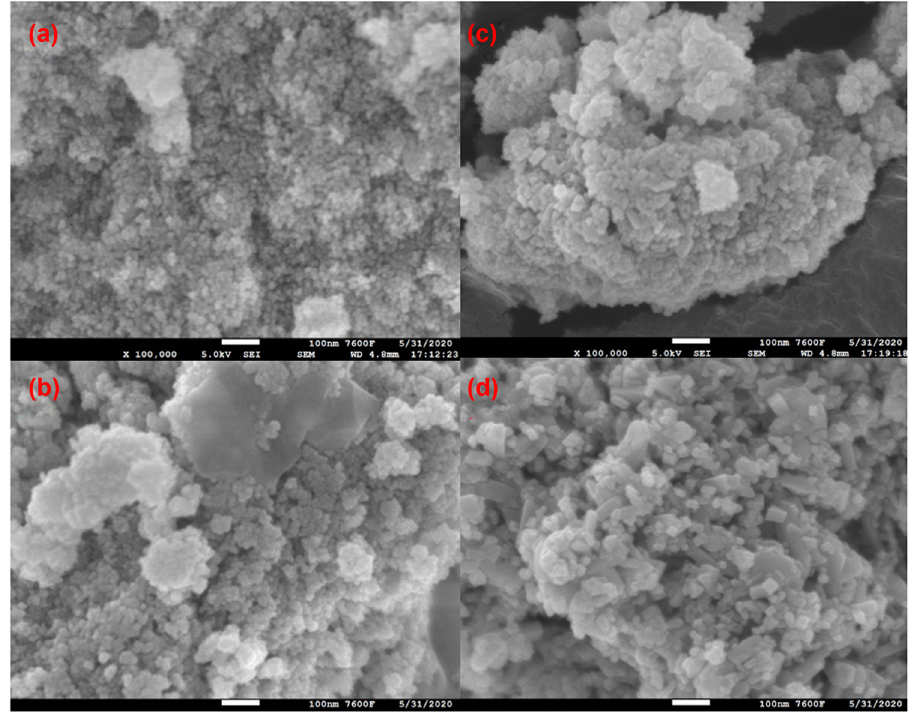
Figure 2: SEM images of the Fe – Sn – O catalyst at di ff erent calcination temperatures of ( a ) 700°C, ( b ) 750°C, ( c ) 800°C, and ( d )